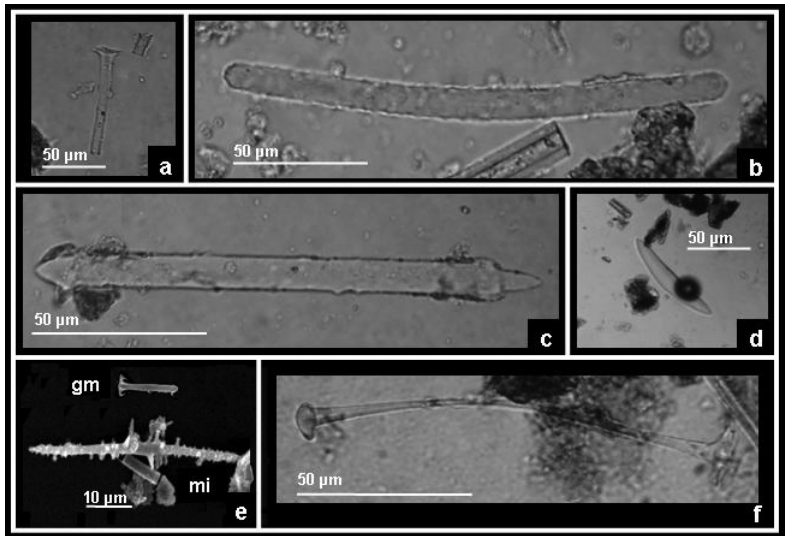
Fig. 5. Scanning Electron Microscope images (a, b, c, f) and Optical Microscope picture (e) of the sponge spicules found in the rocks of the Cemitério paleolake. a. Heterorotula fistula Volkmer-Ribeiro and Motta (1995): fragment of long gemmosclere; b. Corvospongilla seckti Bonetto and Ezcurra de Drago (1966): megasclere; c. Eunapius fragilis (Leidy 1851): gemmosclere; d. Oncosclera navicella (Carter 1881): gemmosclere; e. Metania spinata (Carter 1881): microsclere (mi) and fragment of gemmosclere (gm); f. Corvomeyenia thumi (Traxler 1895): gemosclere.